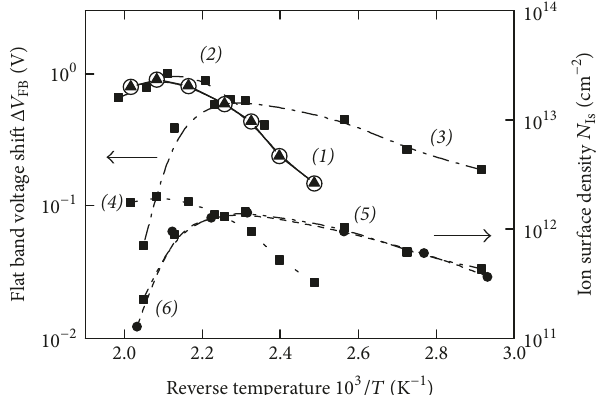
Figure 3: Temperature dependencies of the frat band voltage shift Δ𝑉 (1–3) and the ones of the reduced mobile ion density 𝑁 FB 6) for the MOS stacks with different values of 𝑁 4) — 5 ⋅ 10 11 ; (3, 5) — 4 ⋅ 10 12 . Substrate: (1, 3–5) — 𝑛 -Si, (2) — 𝑝